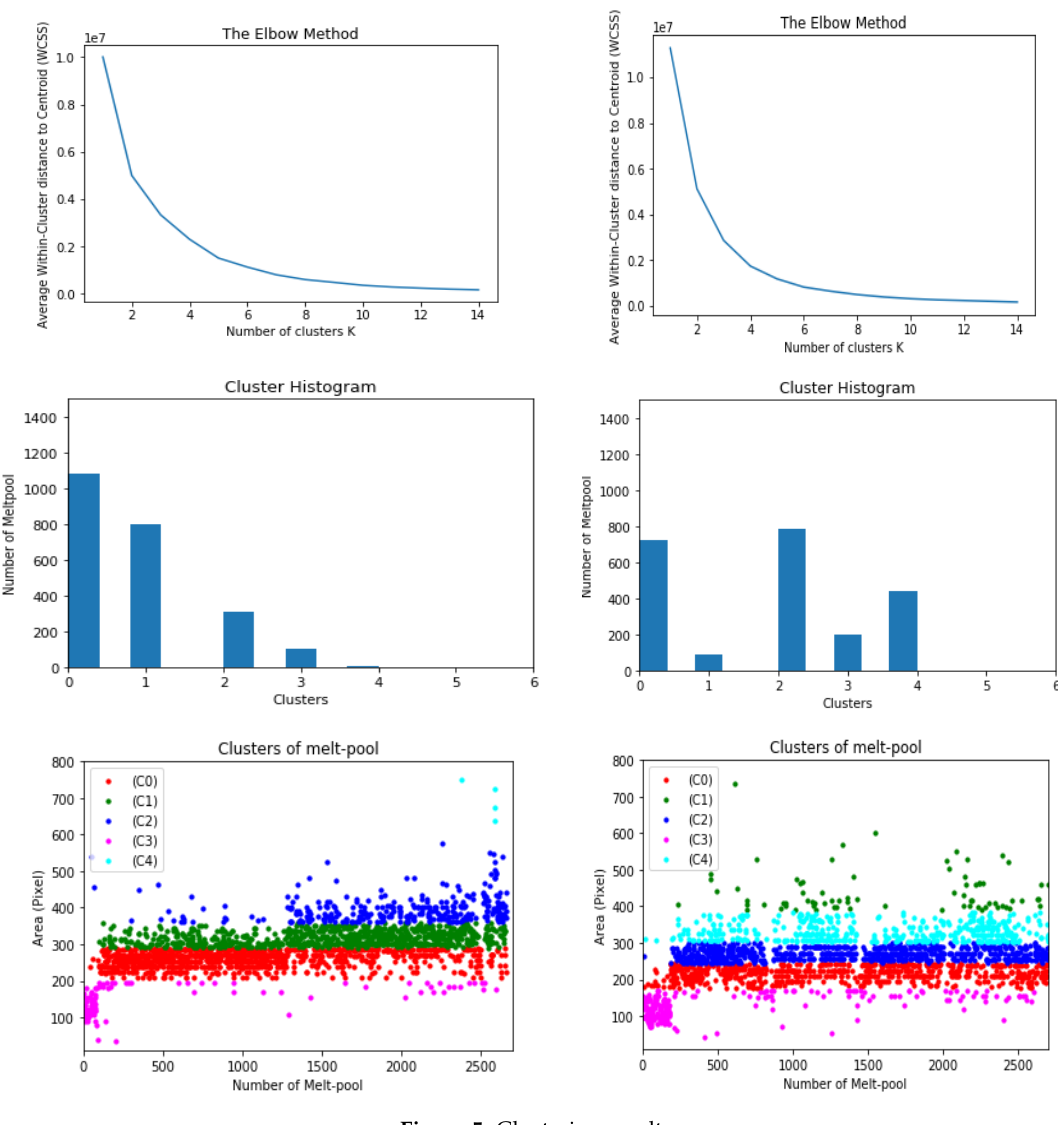
Figure 5. Clustering result.